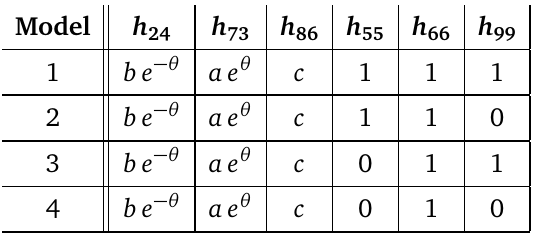
Table 1: Nonzero elements of the Hamiltonian density for models 1-4. Also, a , b and c are constants.